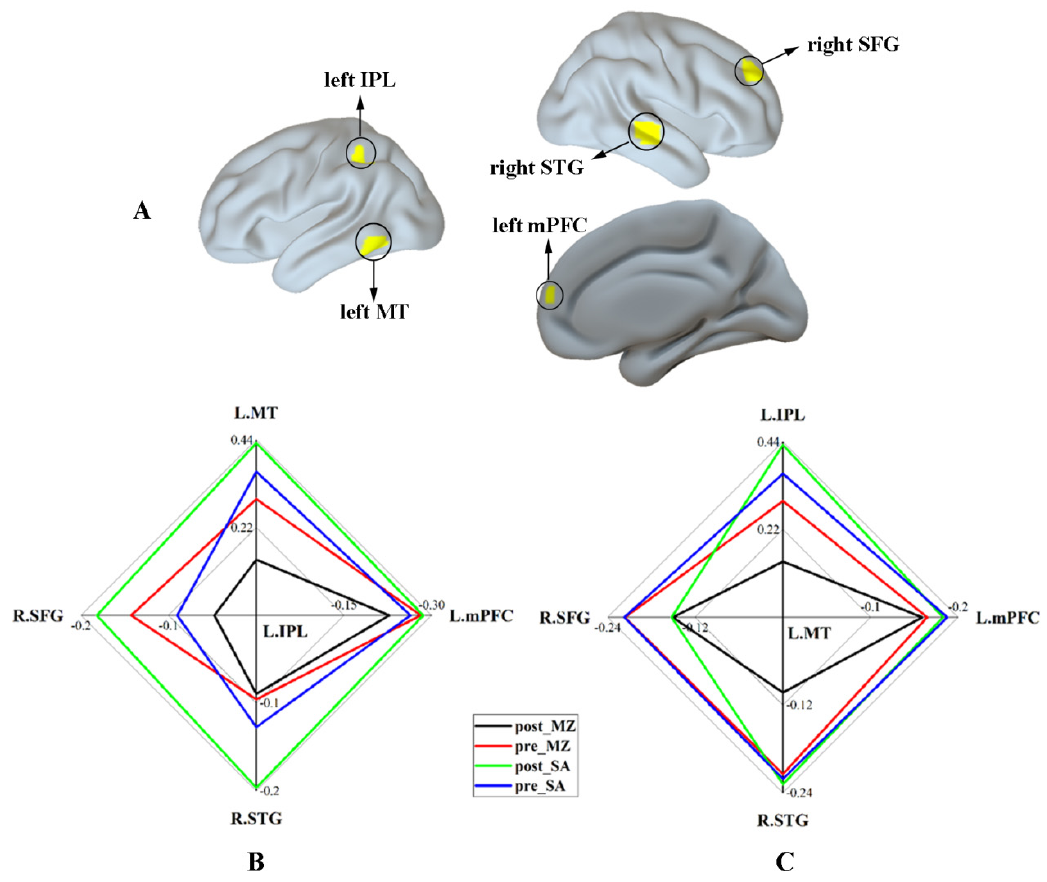
Figure 6. The relative strength of functional connectivity for the regions with a significant interaction effect. ( A ) The regions that revealed a significant interaction effect within DAN and DMN. ( B ) The functional connectivity strength between the left IPL and other regions with a significant interaction effect under different conditions. ( C ) The functional connectivity strength between the left MT and other regions with a significant interaction effect under different conditions. Abbreviations: IPL, inferior parietal lobule; MT, middle temporal area; mPFC, medial prefrontal cortex; STG, superior temporal gyrus; SFG, superior frontal gyrus; MZ, midazolam; SA, saline.